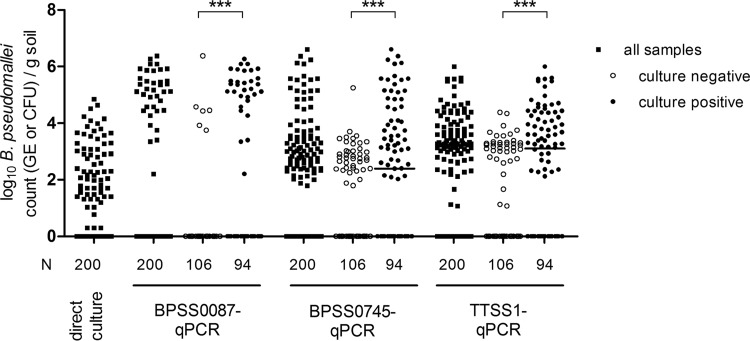
Comparison of B. pseudomallei GE detected by the various assays of culture-positive and -negative samples. Scatter plot (with medians) comparison shows log10-transformed B. pseudomallei CFU per gram soil as determined by direct culture and log10-transformed B. pseudomallei GE per gram soil as determined by qPCR assays. N denotes number of samples per group. ***, P < 0.001 by a Mann-Whitney U test.